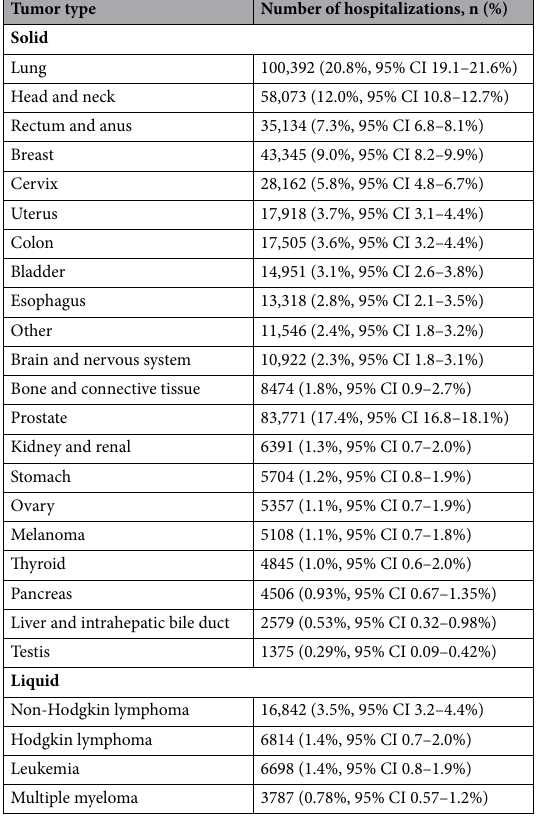
Table 1. Hospitalizations for complications of radiotherapy by tumor types,